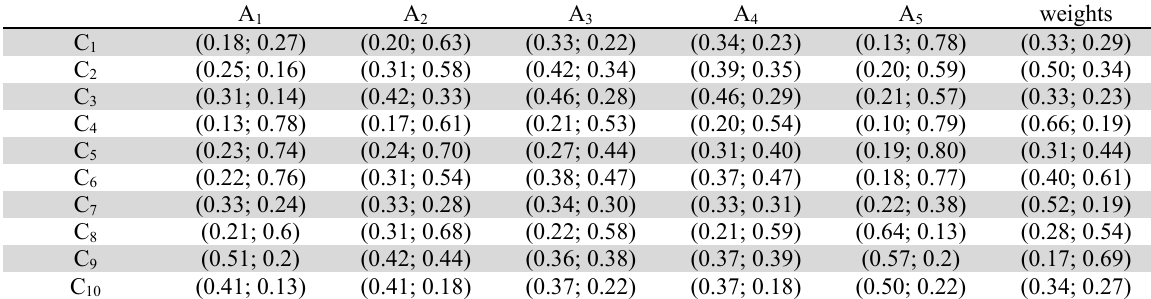
The intuitionistic fuzzy valued decision matrix and weights